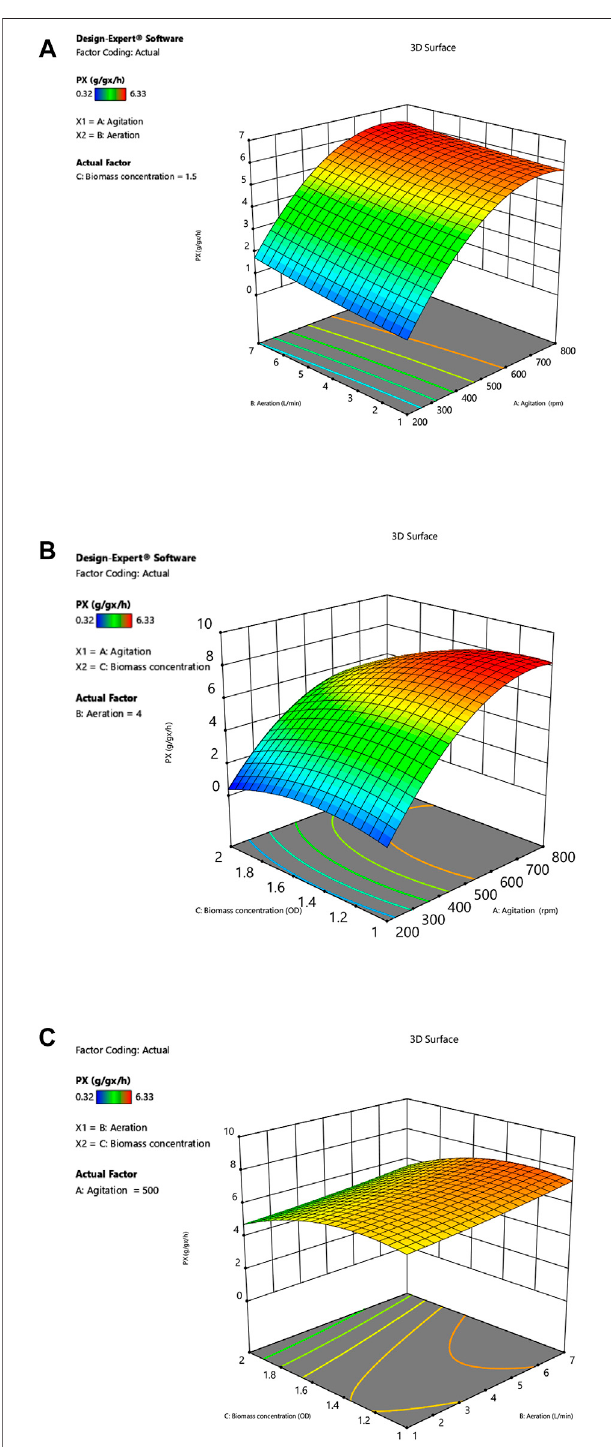
FIGURE 2 | (A) Interactive effect of agitation and aeration on P X . (B) Interactive effect of agitation and biomass concentration on P X . (C) Interactive effect of aeration and biomass concentration on P X